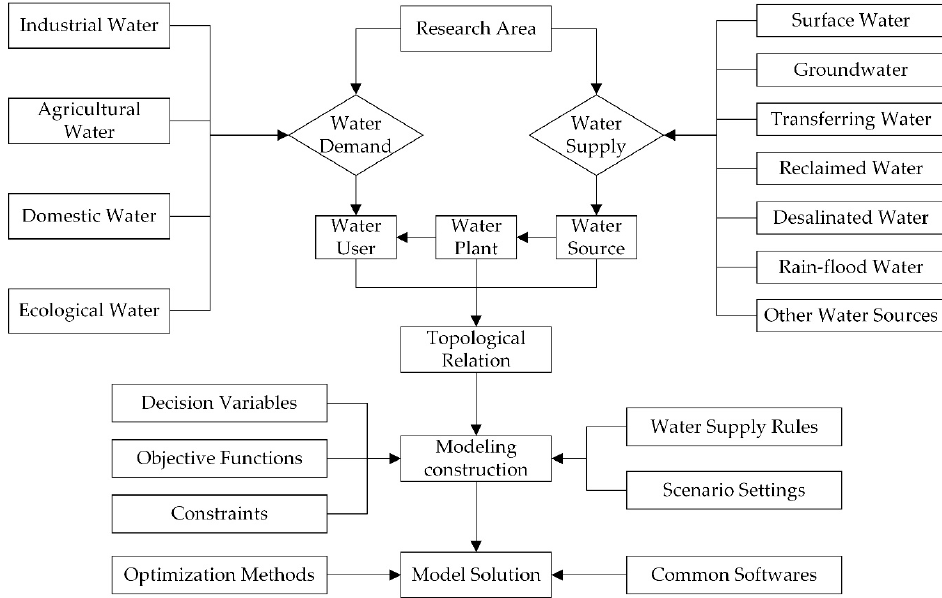
Figure 3. The flow chart of research on multi-source water supply.